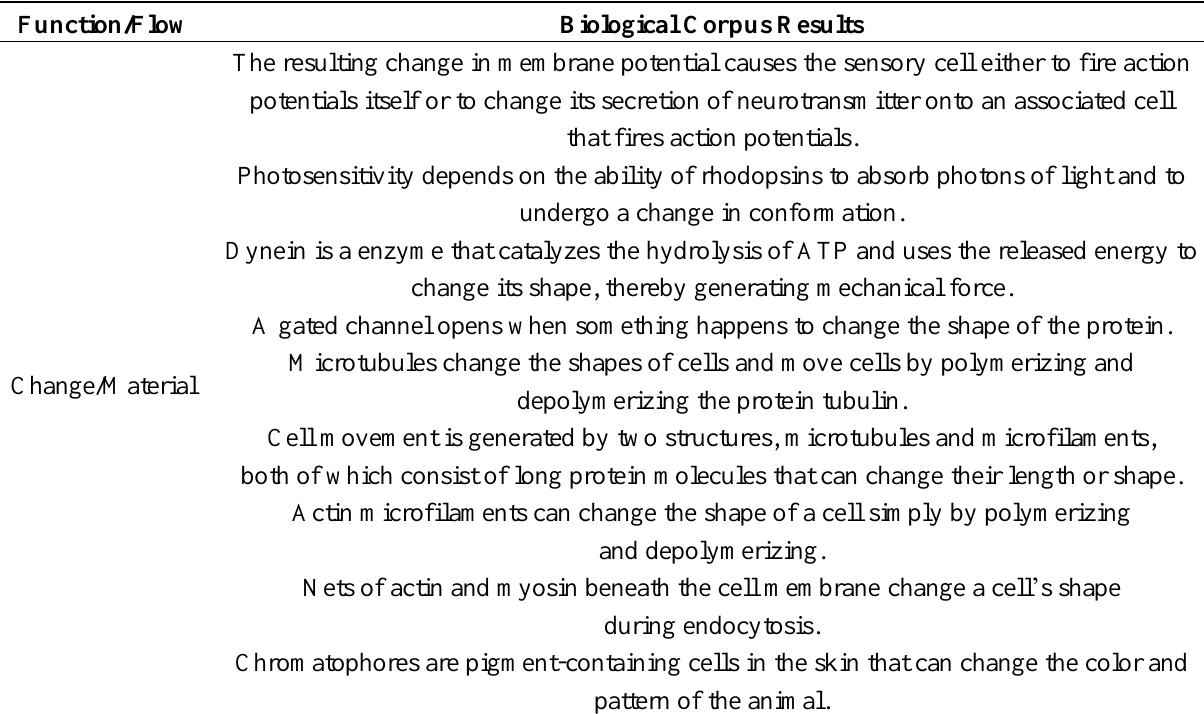
Table 4. Biological corpus results mapped to the function/flow pair change